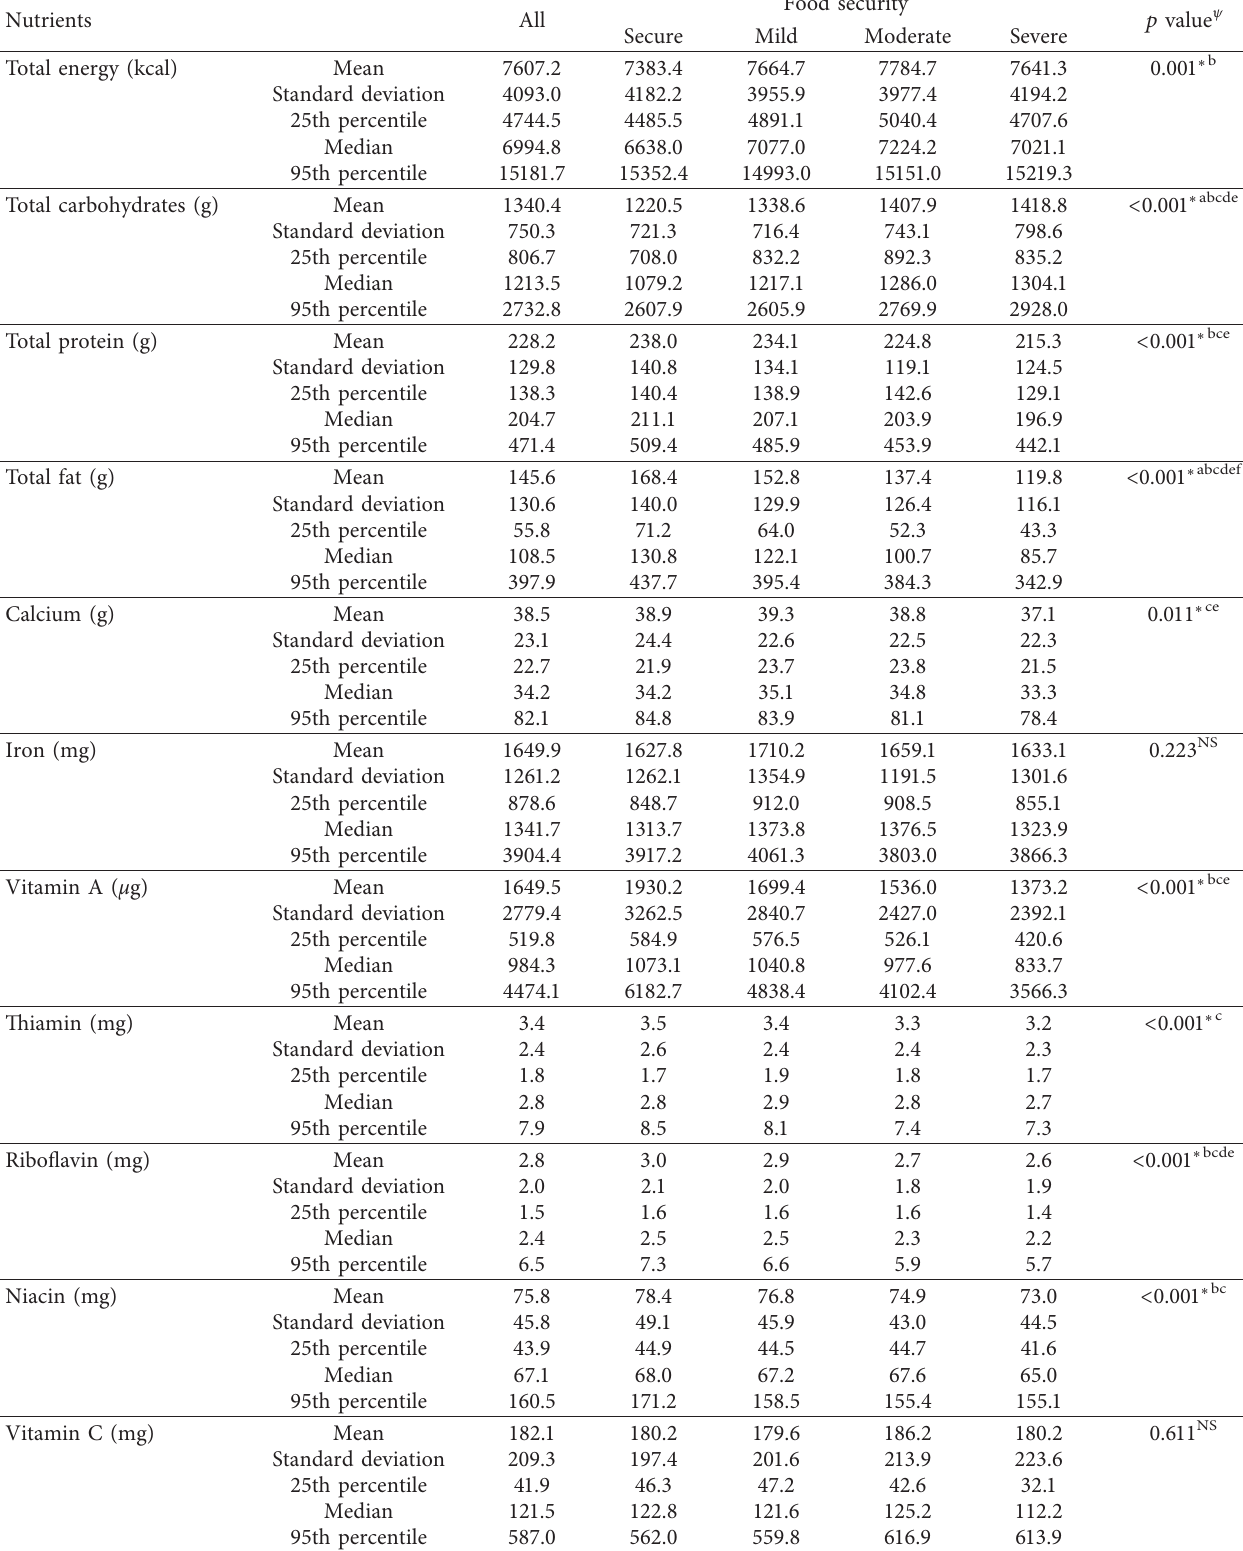
Table 7: Distribution of household’s total energy and nutrient intakes by the food insecurity level.